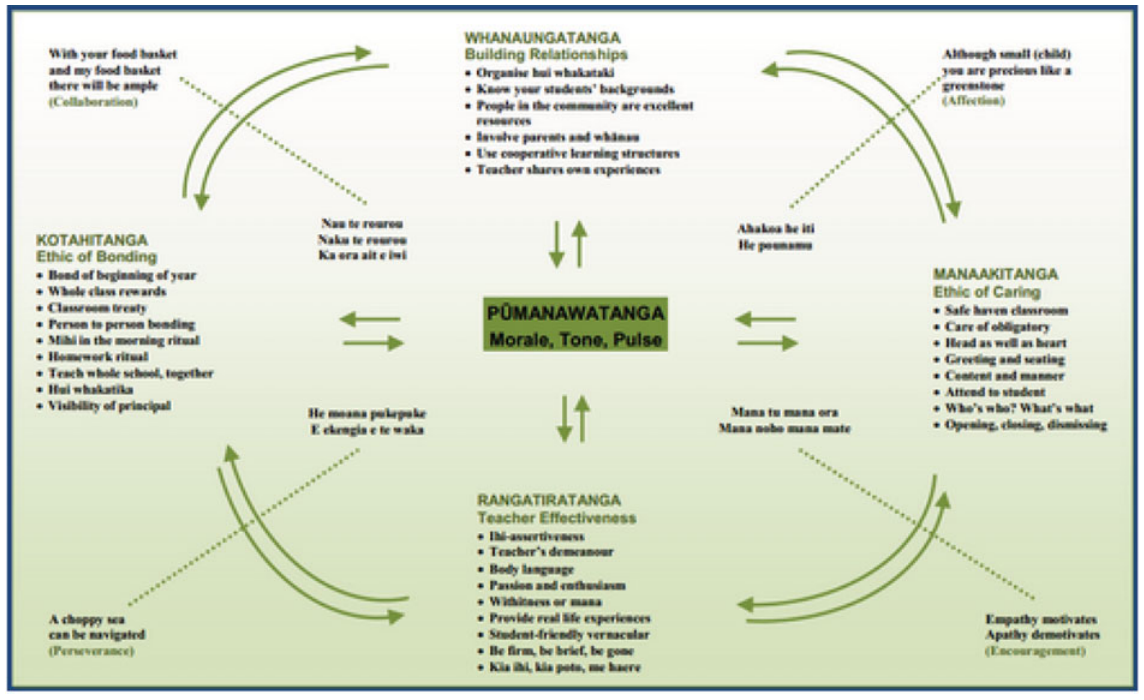
(Colour online) The Educultural Wheel (Macfarlane,